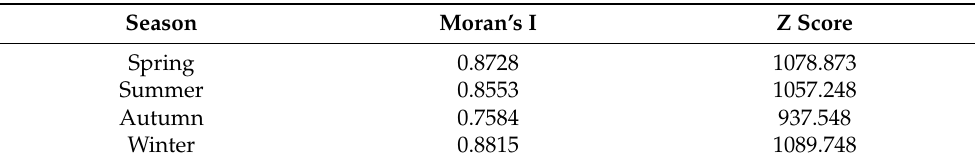
Table 4. Local spatial autocorrelation of seasonal ozone concentration in the Pearl River Delta Metropolitan